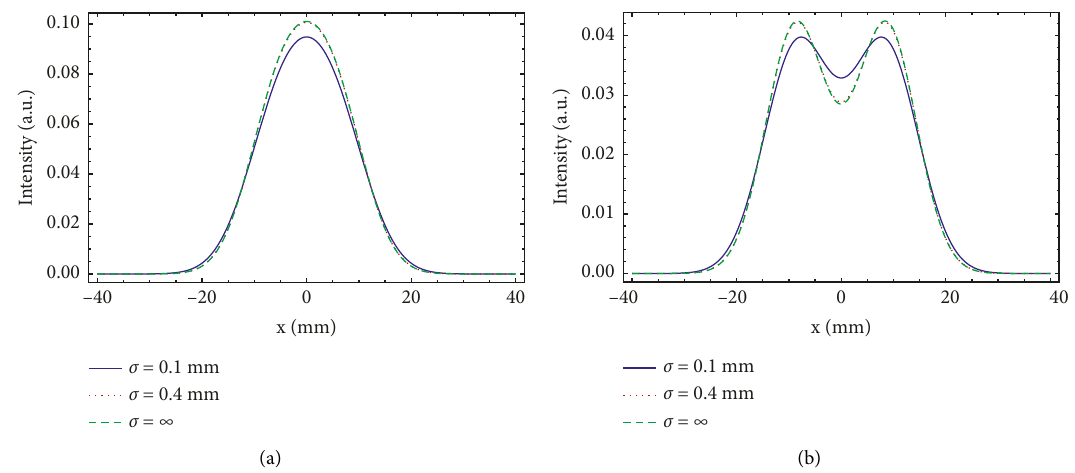
n 2 ( z 1m). 1 (cid:25) (cid:26) (cid:30)